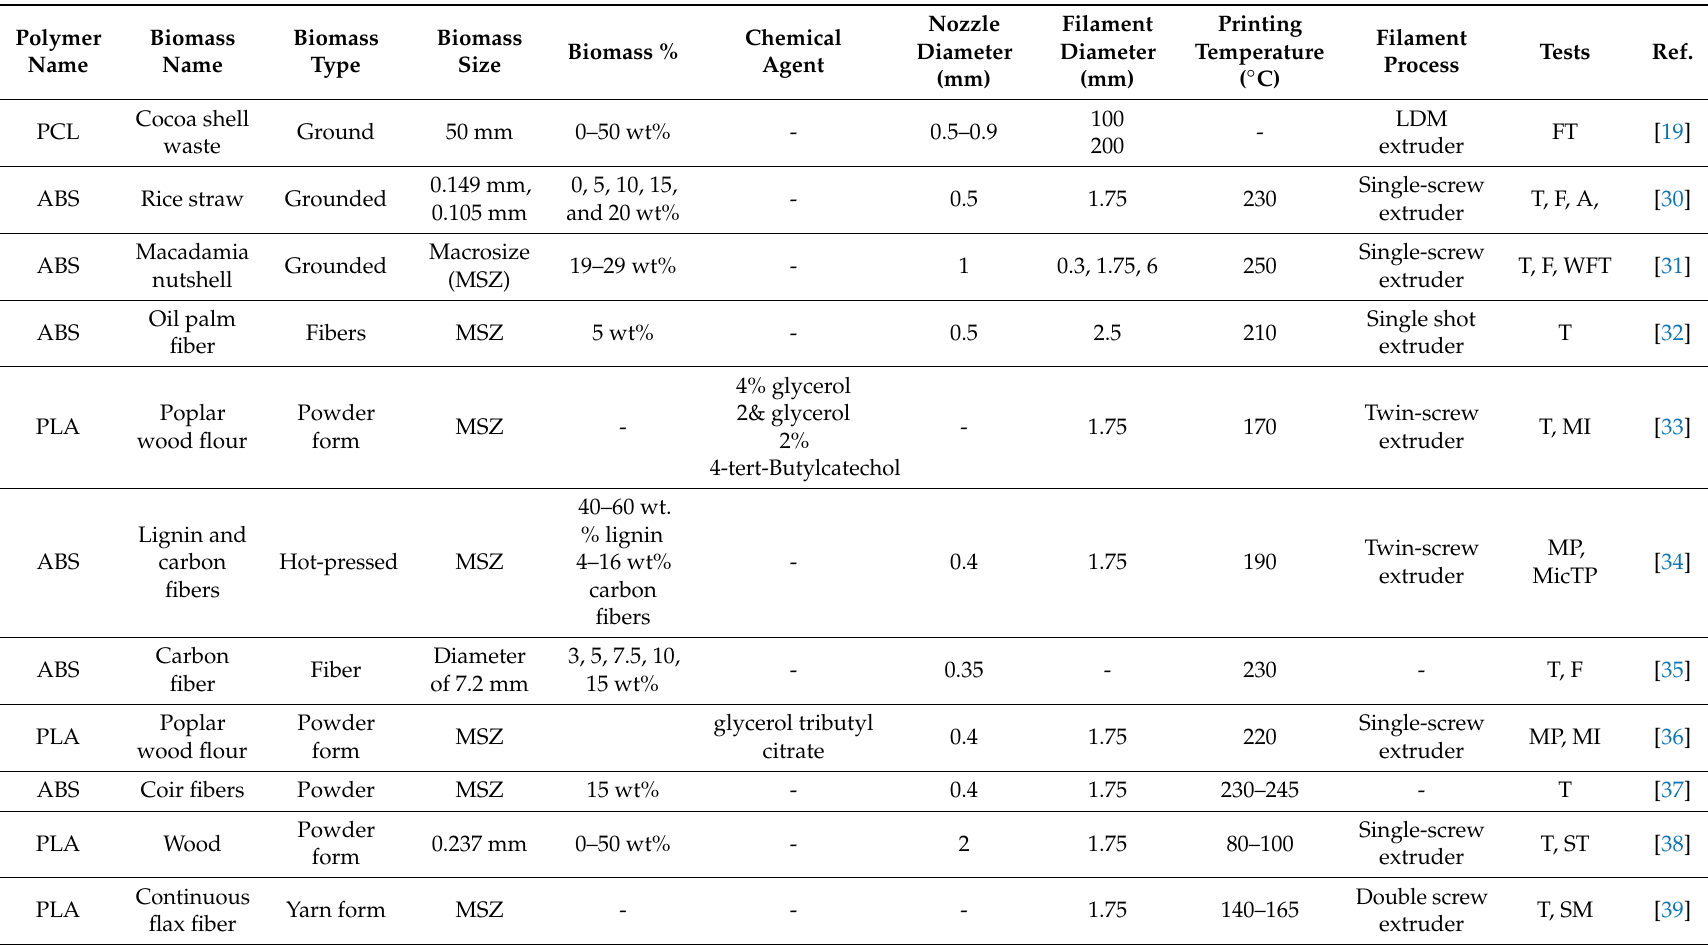
Table 2. Biomass and Printing Parameters in Reviewed